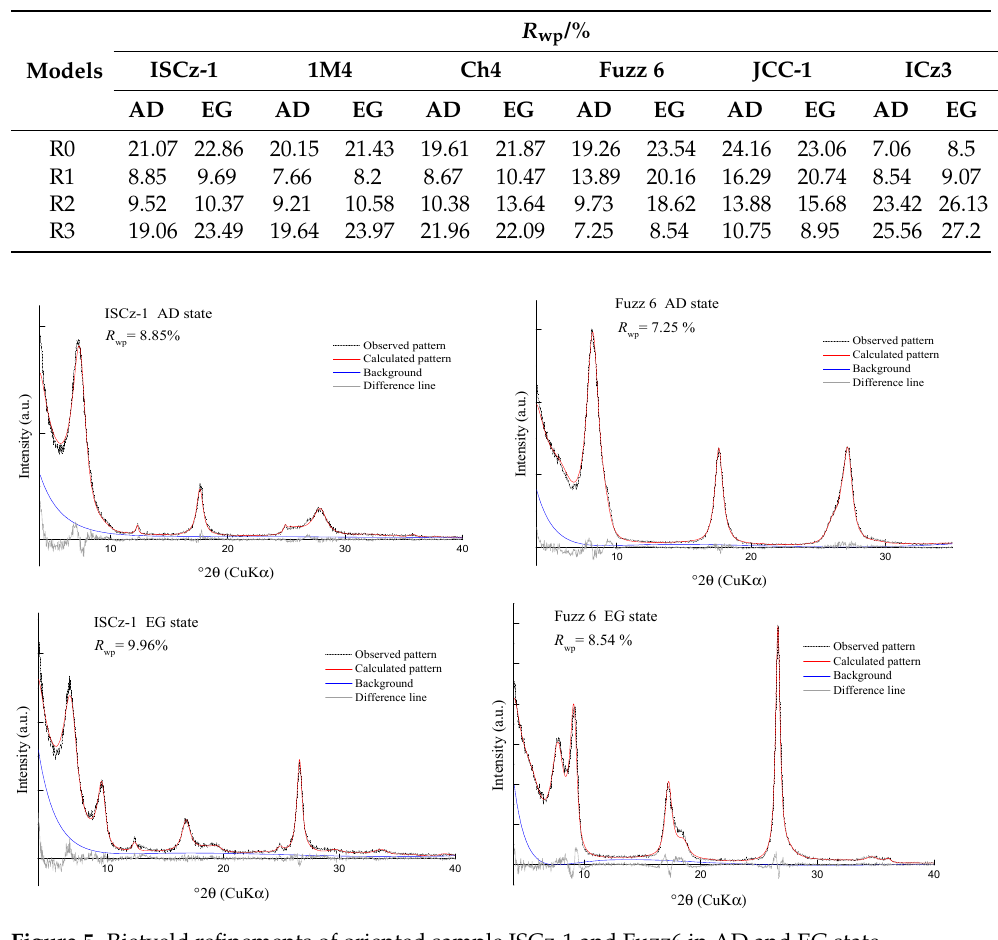
Figure 5. Rietveld refinements of oriented sample ISCz-1 and Fuzz6 in AD and EG